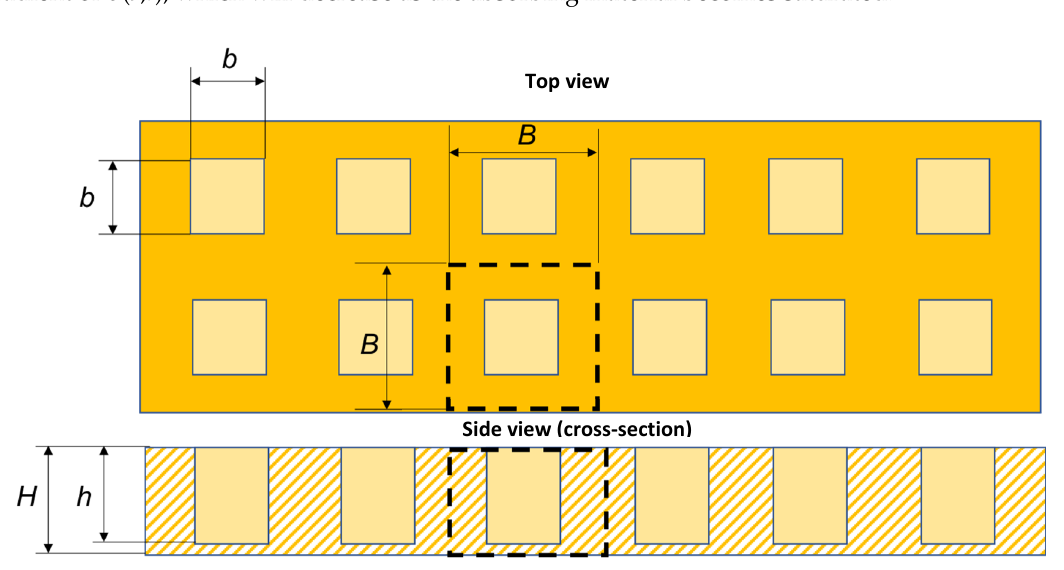
Figure 2. Sketch of the computational model for studying the effect of an increased interface area (the cell of interest is marked with dashed lines).